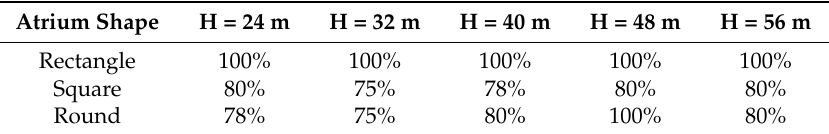
Table 4. Glazing-size guide for